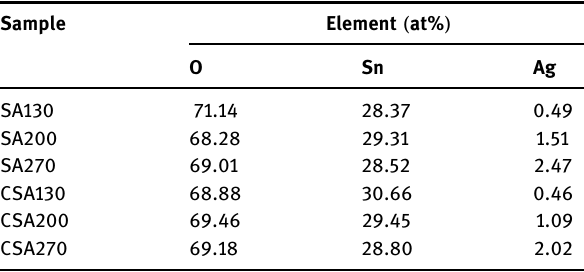
Table 1: Composition ( O, Sn, and Ag ) of various thin - fi lm samples from SEM – EDS spectra analysis